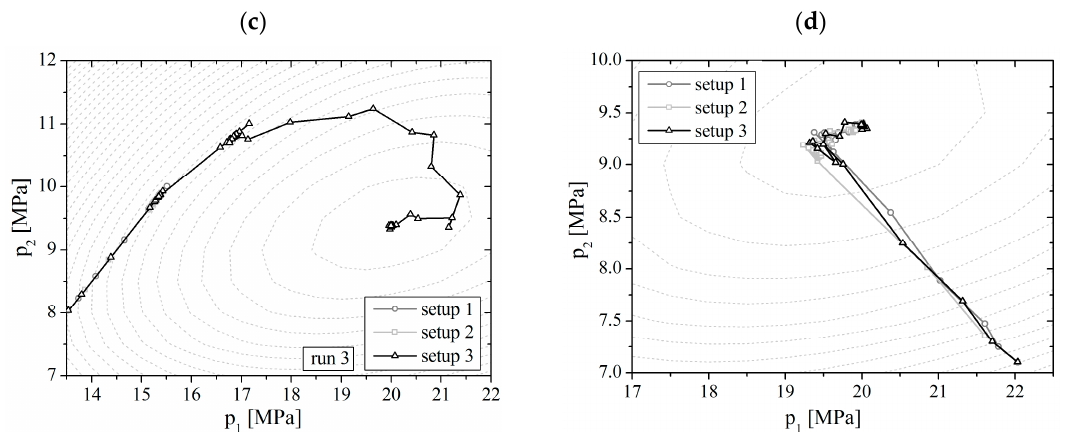
Figure 4. The evolution of the iteration procedure for three different NM operating conditions, for run 1 (a), run 2 (b), run 3 (c) and run 4 (d).